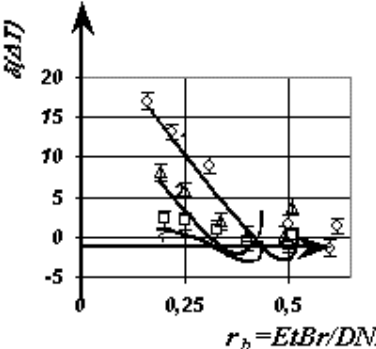
FIGURE 1. Melting curves of complexes of DNA-EtBr at ionic strength µ 1), µ = 1,0 ⋅ 10 -2 М (curve 2), µ Na + deviation errors are